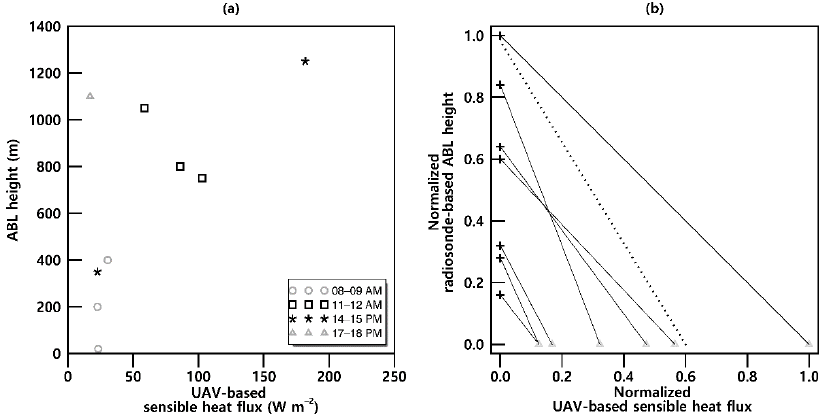
Figure 9. ( a ) Radiosonde-observed atmospheric boundary layer (ABL) heights and UAV-based heat fluxes (H b_UAVUAV ) estimated using the bulk transfer method and ( b ) relationship between normalized ABL height and normalized sensible heat flux.